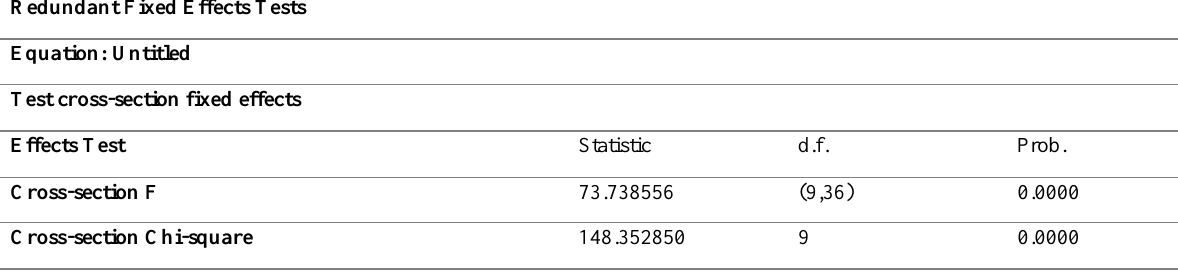
Table 1: Chow Test